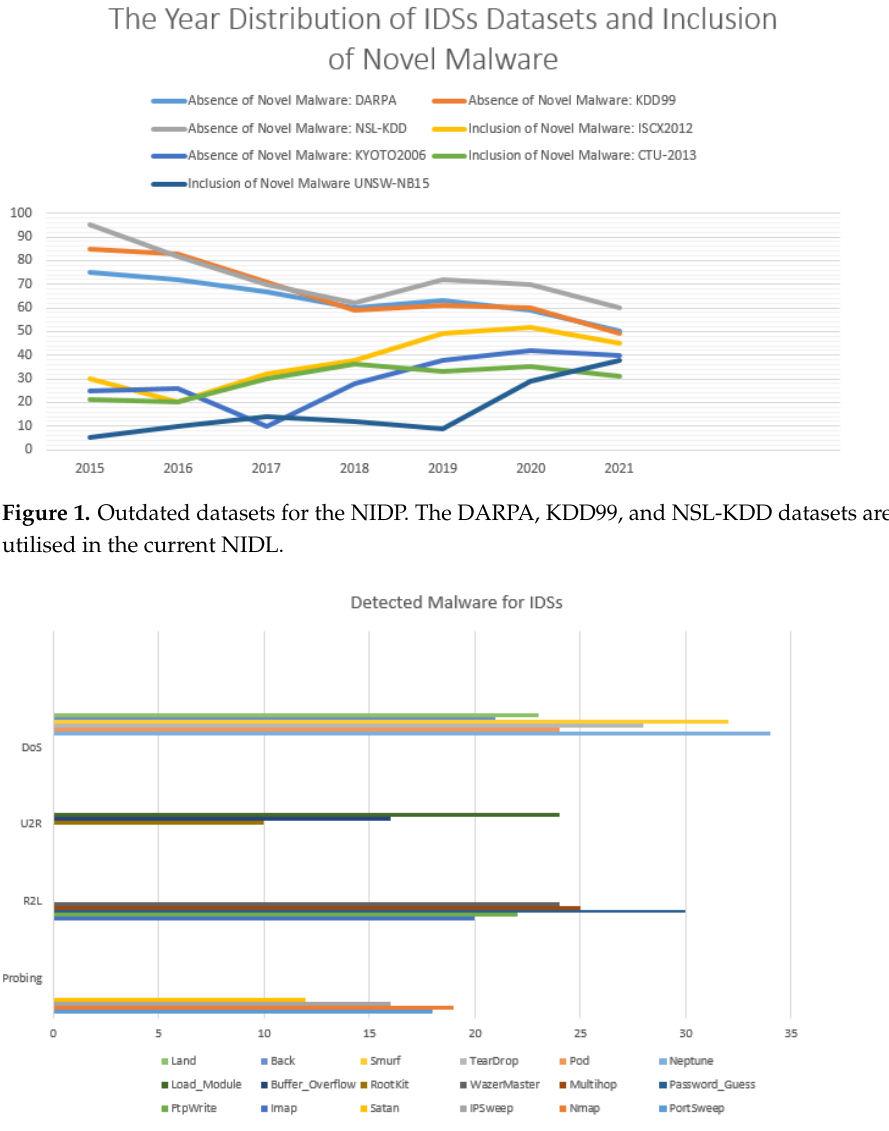
Figure 2. Legacy network threats for the NIDP. The U2R, R2L, DoS and Probing are the most recurrent network threats detected for the